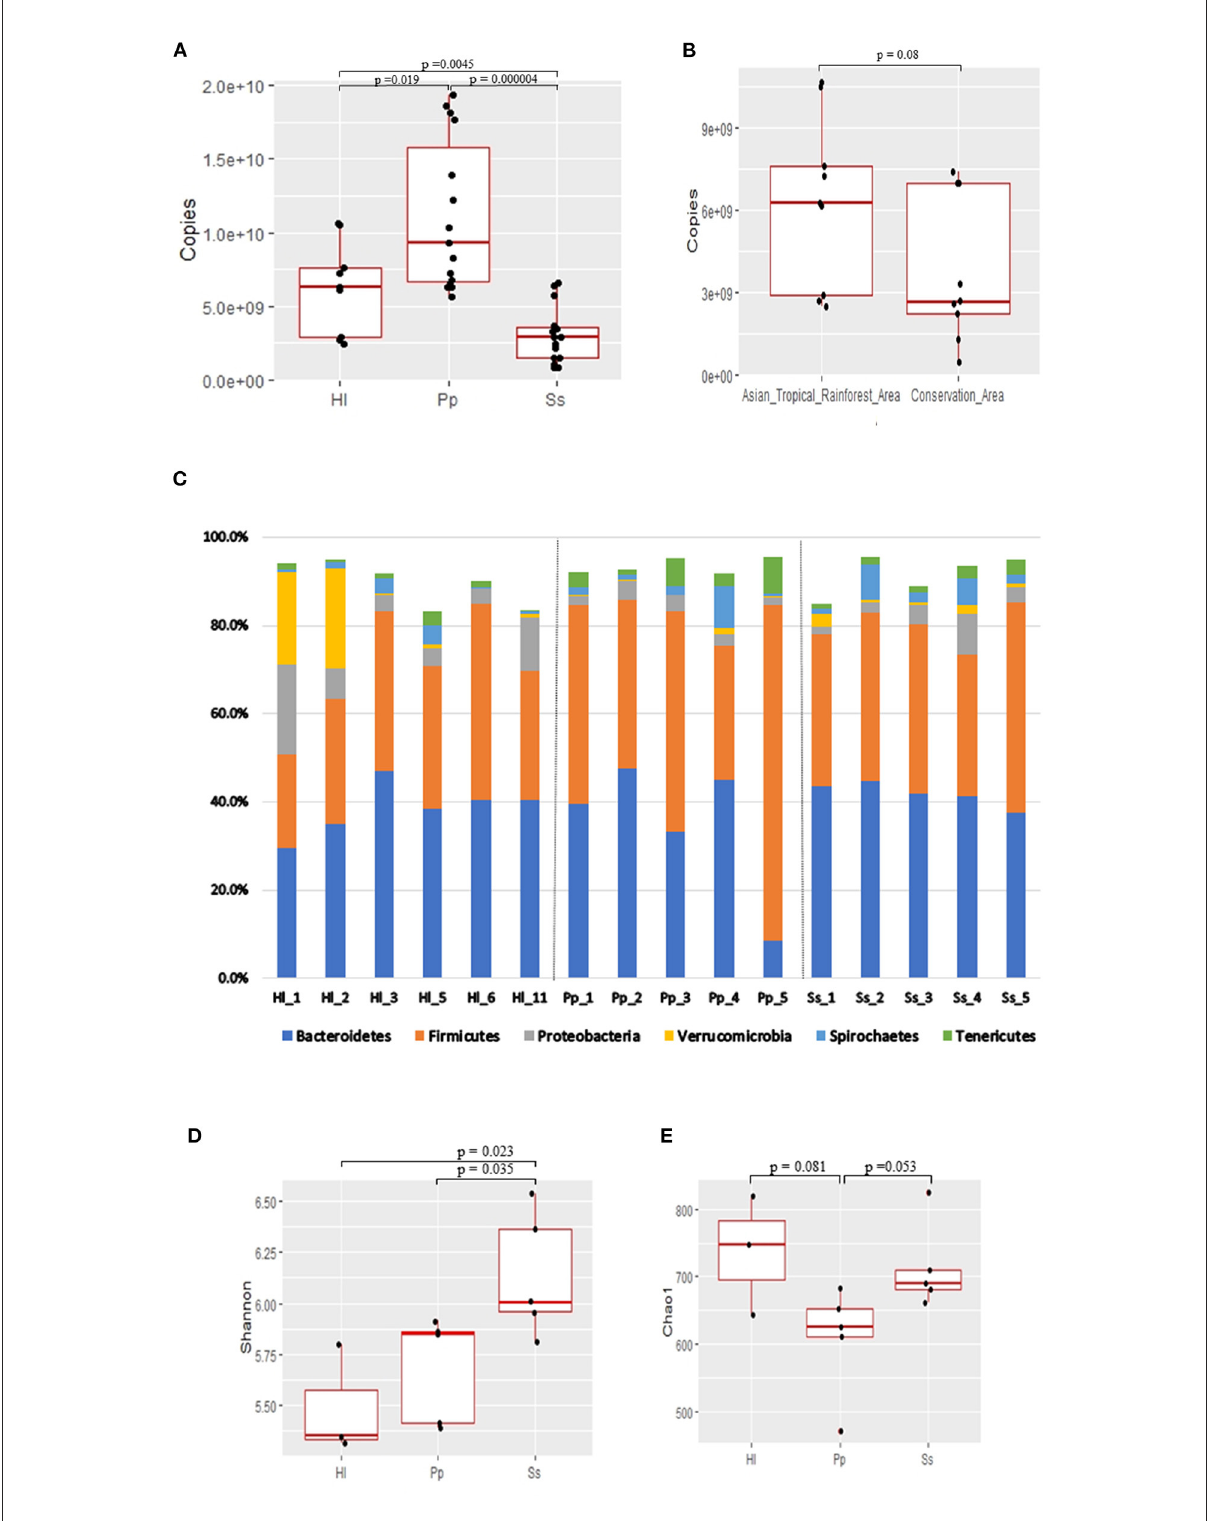
FIGURE1 Abundance, composition, and alpha-diversity of fecal microbiomes of white-handed gibbons (Hl), Bornean orangutans (Pp), and siamangs (Ss). (A) Copies of the 16S rRNA gene per gram of feces were determined for the cohorts housed in the Asian tropical rainforest area. Hl, n = 3; Pp,